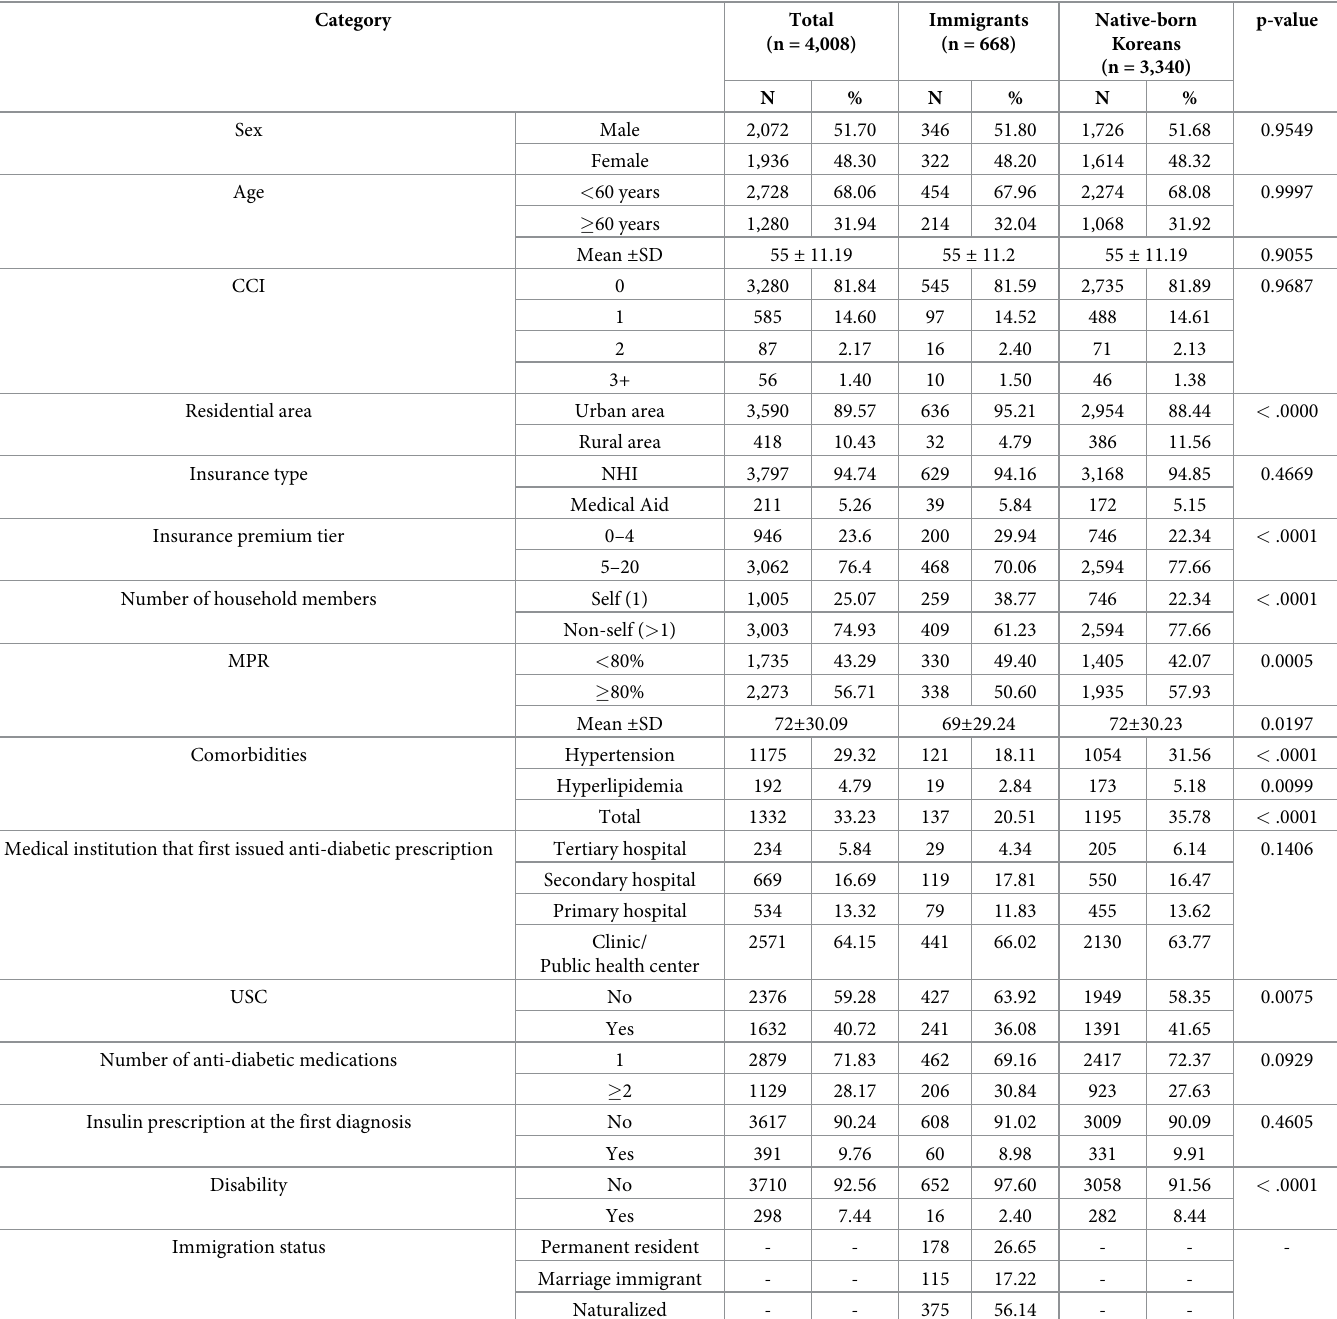
Table 1. Characteristics of immigrants and native-born Koreans with